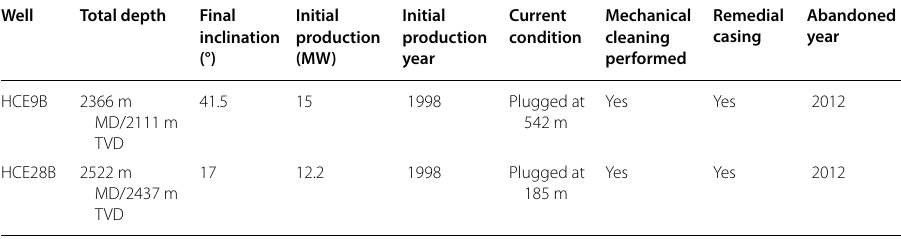
Table 2 Summary of well condition (Marbun 2013; PT Geo Dipa Energi